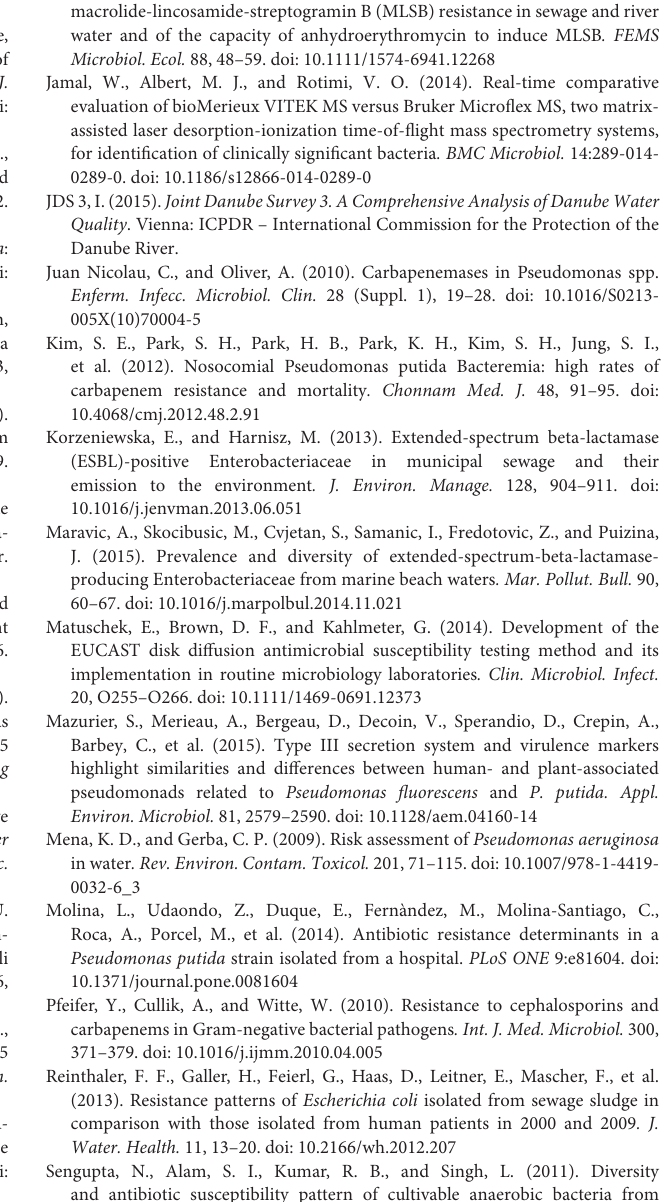
Supplementary Figure S1 | Figure of the JDS3 River Danube Survey (high resolution.pdf). Supplementary Table S1 | Table of all Pseudomonas spp. isolates with resistance pattern. (TZP), Piperacilin/tazobactam; (CAZ), ceftazidime;